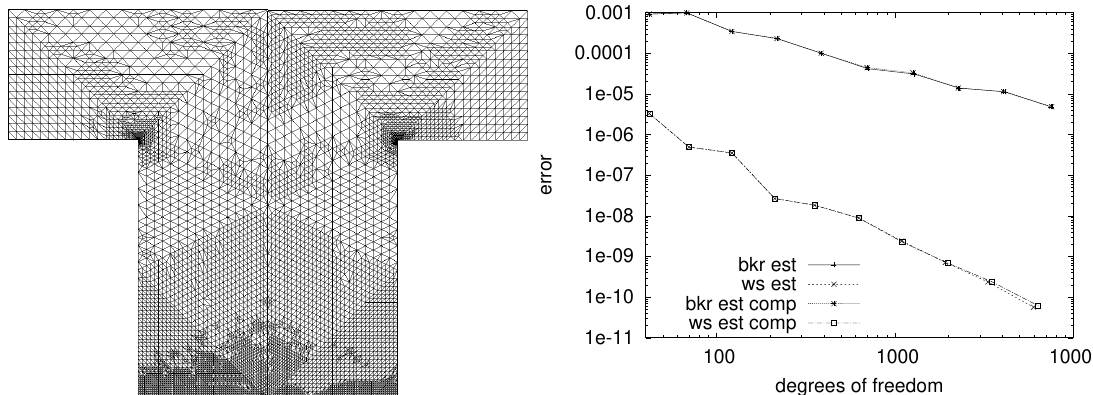
Figure 9. Goal-oriented error estimation: generated meshes with (left) and without (middle) compression (with compression factor up to 32) for Example 3b in [87]. Meshes were generated using weights according to Weiser [87]. Estimated errors (right) are shown for weights due [87] (ws) and to Becker et al. [85] (bkr), both with and without compression. Differences between estimated errors with and without compression are barely visible, and negligible compared to the differences between the two error